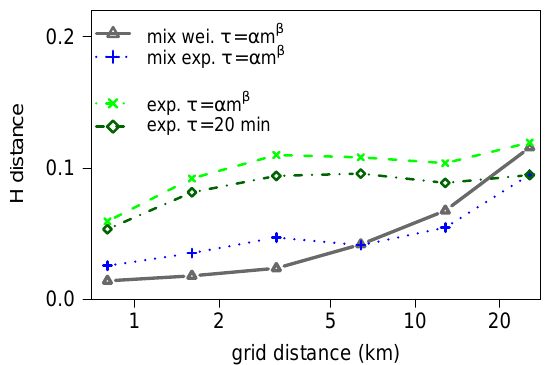
Figure 10. Comparison of the Hellinger distance between the distri- bution pairs from simulations using different model configurations: a single exponential (exp.) configuration with and without cloud lifecycles, and a mixed exponential (mix exp.) and mixed Weibull (mix wei.) configuration with explicit cloud